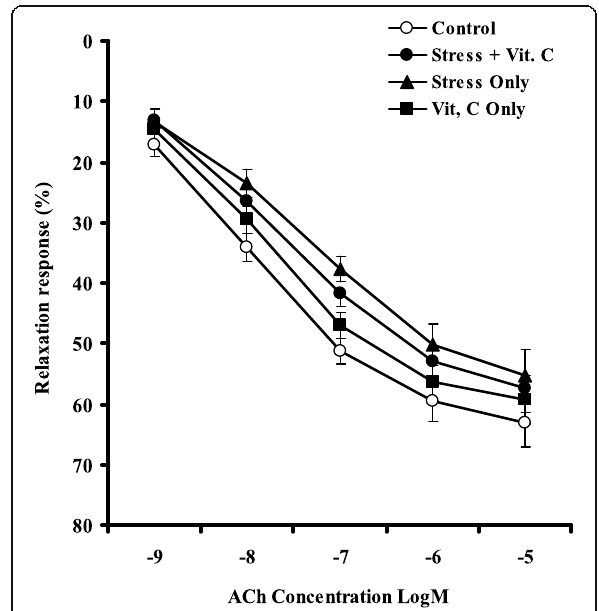
variable stress with vitamin C supplementation on relaxation responses of testicular artery strip to doses of ACh